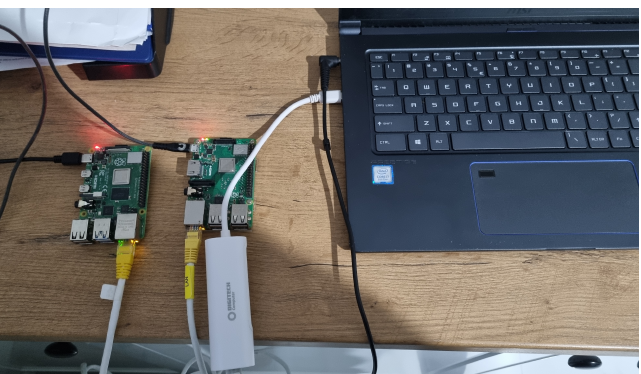
Figure 4. Experiment setup with IoT devices/nodes (RPi 4B), IoT gateway (RPi 3B+), deployment controller